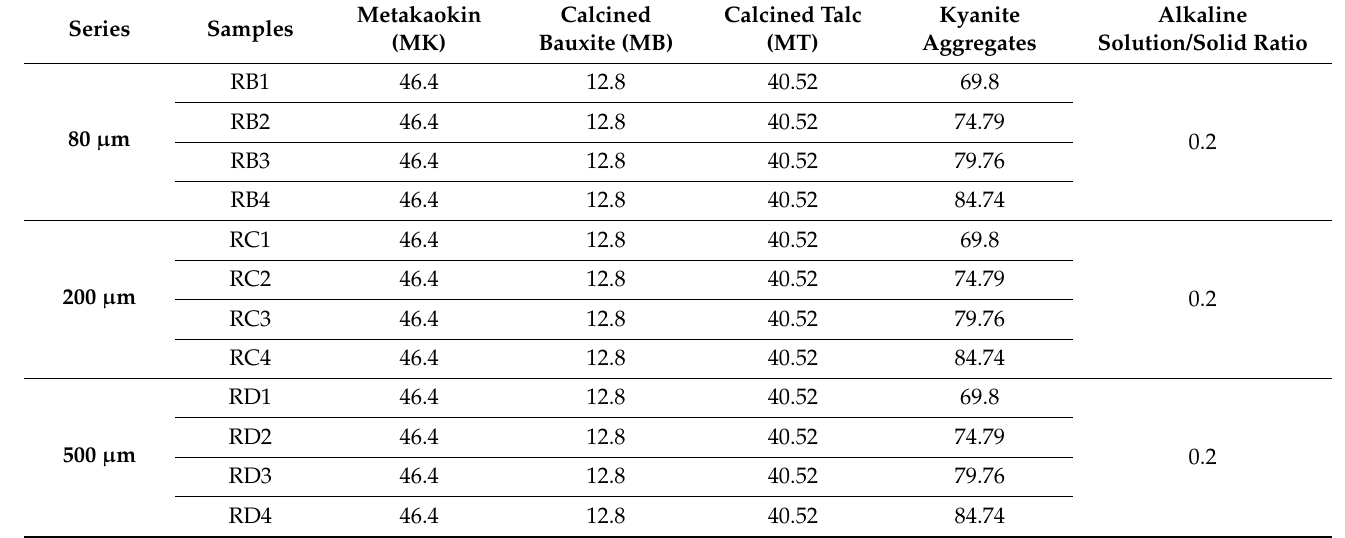
Table 1. Formulation of refractory geopolymer